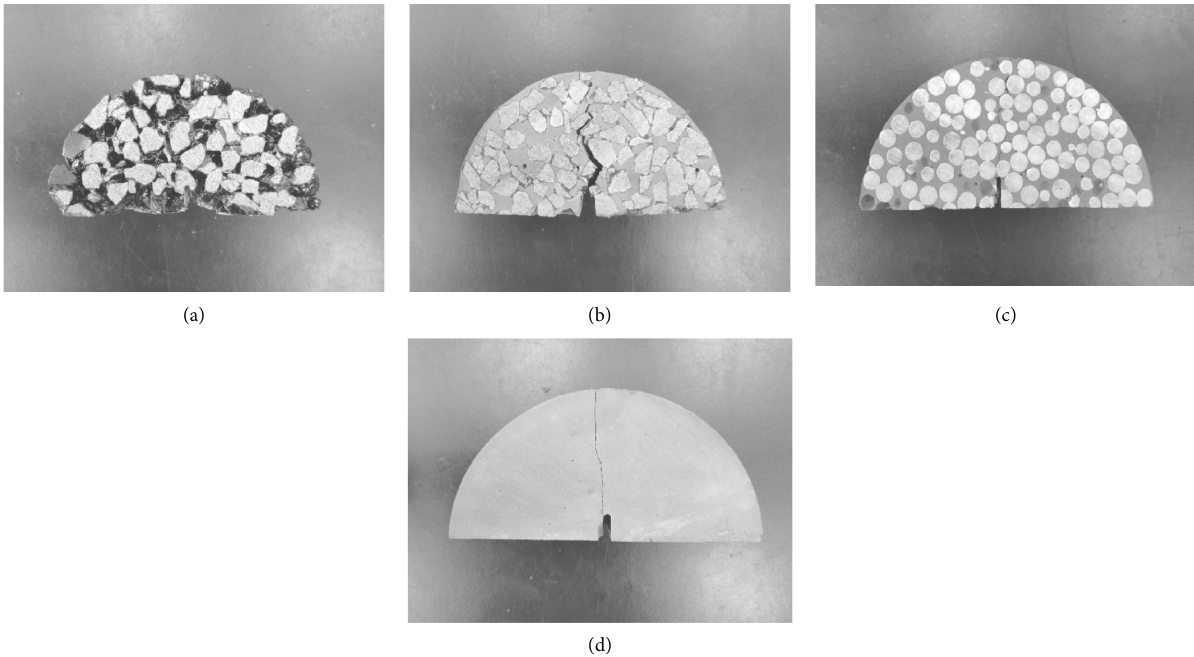
Figure 13: Failed SCB samples. (a) PAM. (b) CCAM. (c) Cement sample with no balls. (d) Cement sample with no balls.